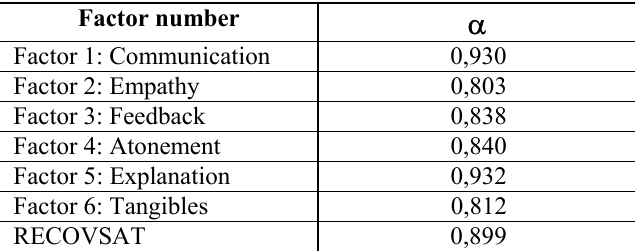
Table 5: The Internal reliability of RECOVSAT